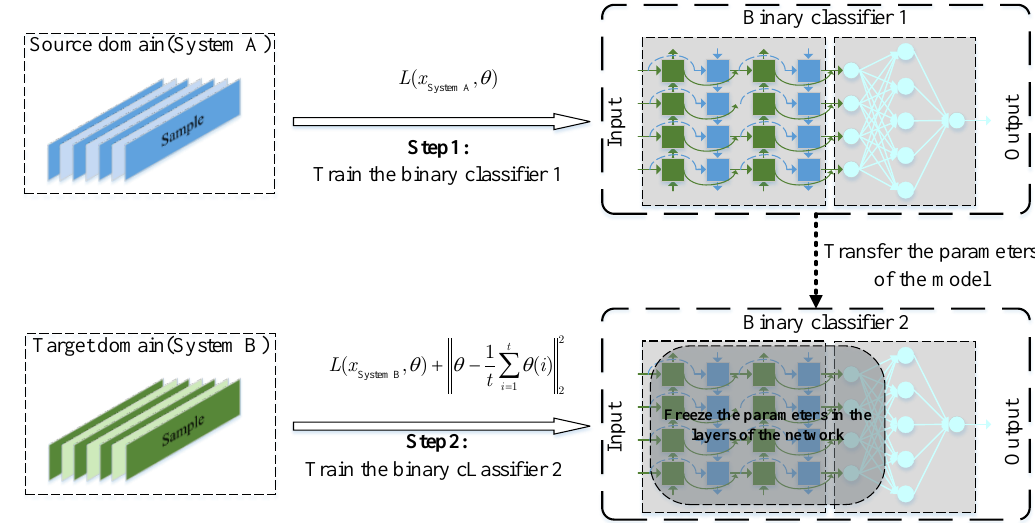
Figure 5. Two-step training strategy for FLS model.